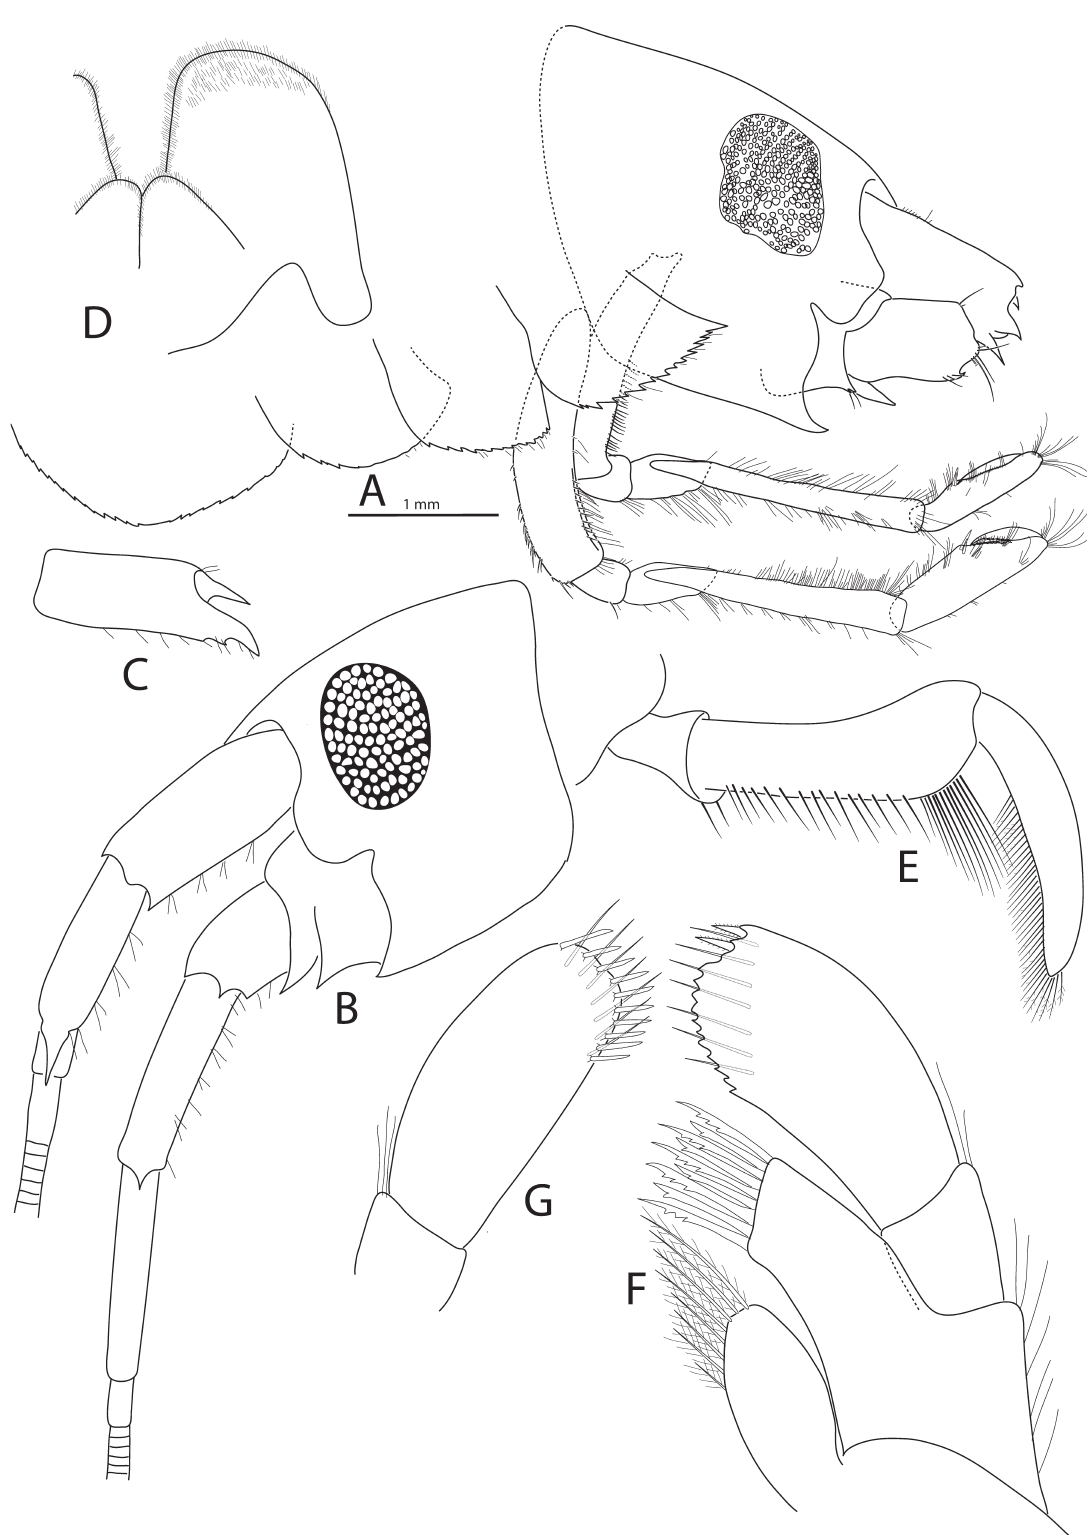
Fig. 10. Halirages stappersi sp. nov., holotype ♂, 20 mm, Kara Sea, RV Belgica stn 132. A . original. B-G . after Stappers (1911). A-B . anterior part of body. C . article 2 of peduncle of left A2. D . lower lip. E . palp of left Md. F . right Mx1 (medial face). G . palp of left Mx1 (medial